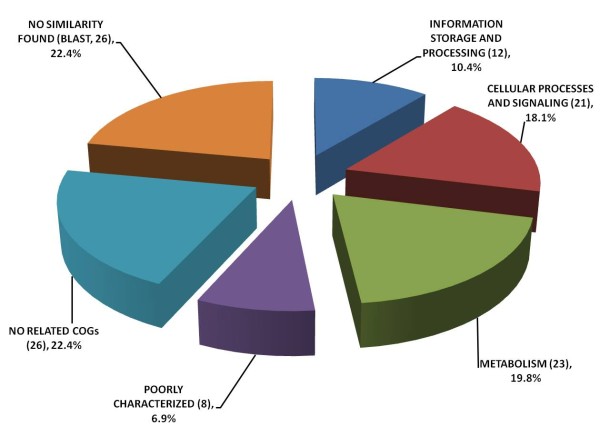
Functional classification of the 116 unigenes from the subtractive libray of GM077 vs BP034. The classification was based on BLASTX and TBLASTX results (E-value < 10-5) using the expressed sequence tags (ESTs) of the unigenes. Genes are categorized using the NCBI KOGnitor COG classification
[43]. The number of unigenes in each group is indicated and their percentage in the total number of unigenes is denoted.